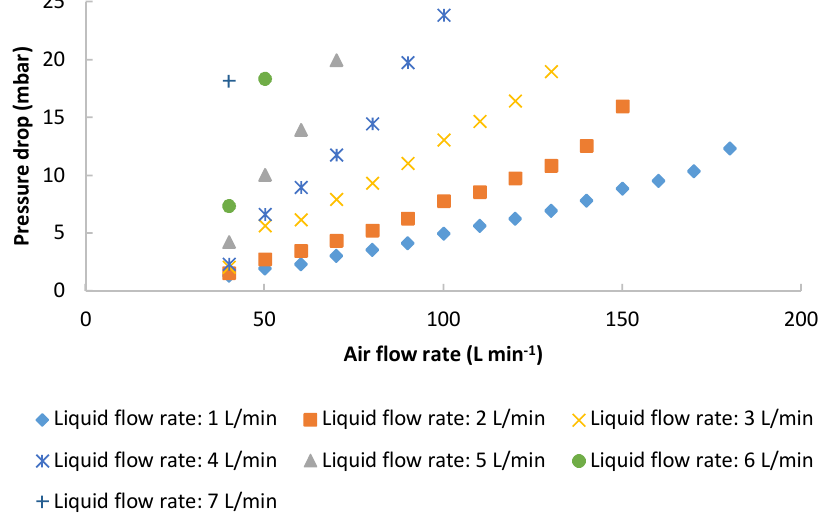
Figure A1. Pressure drop as a function of the air flow rate for different liquid flow rates.